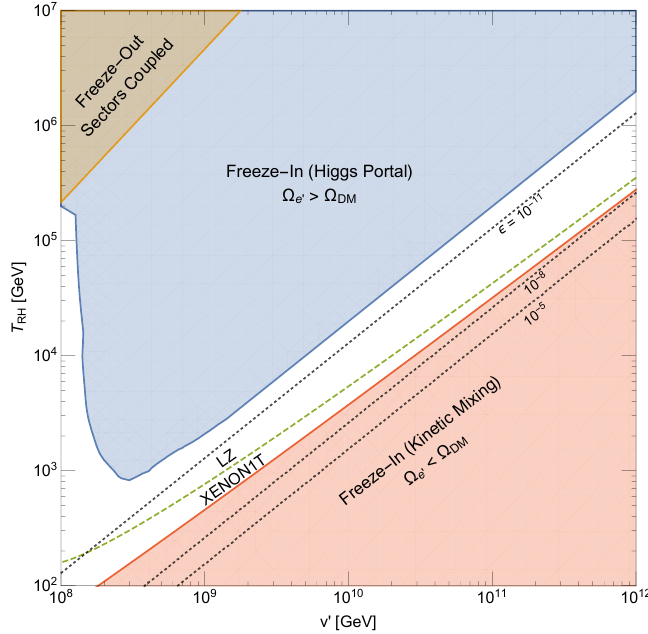
Figure 13 . Constraints on the mirror electroweak scale v 0 and the reheat temperature T RH of the universe. In the blue region, e 0 is overproduced via freeze-in from the Higgs portal. In the red region, the required (cid:15) to freeze-in e 0 as DM via the kinetic mixing portal (shown by the dotted counters) is large enough to produce nuclear recoil signals in XENON1T. In the orange region, the reheat temperature is high enough that the two sectors were originally thermally coupled and the freeze-in regime reduces to the freeze-out regime (see section